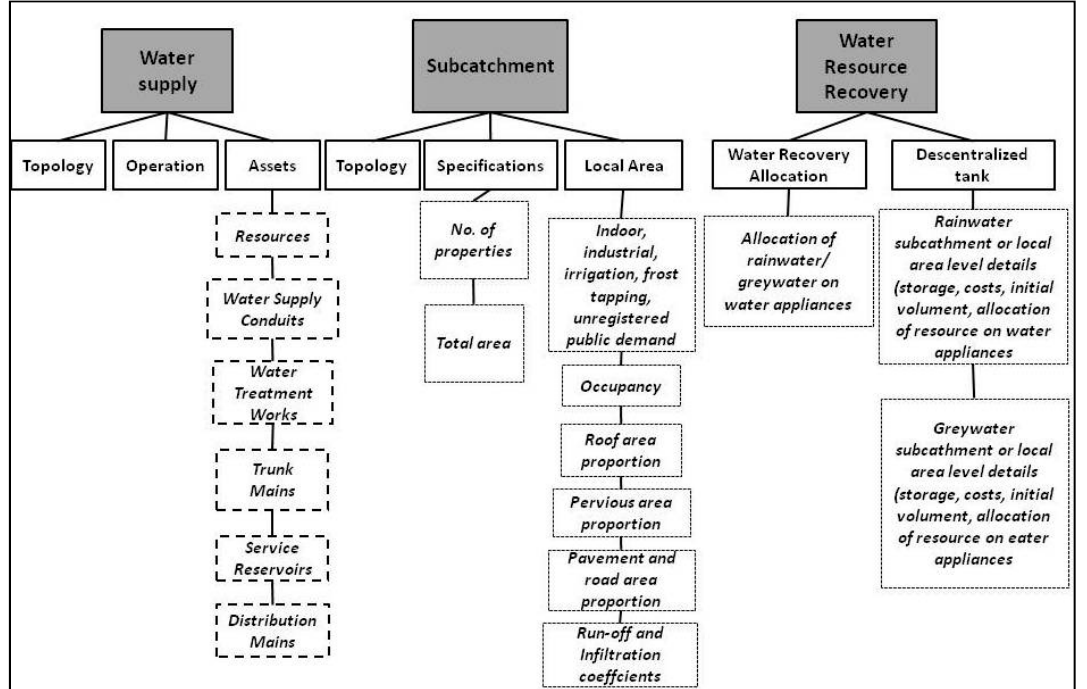
Figure 3. Main Urban Water Systems (UWS) components used in the WaterMet 2 model.